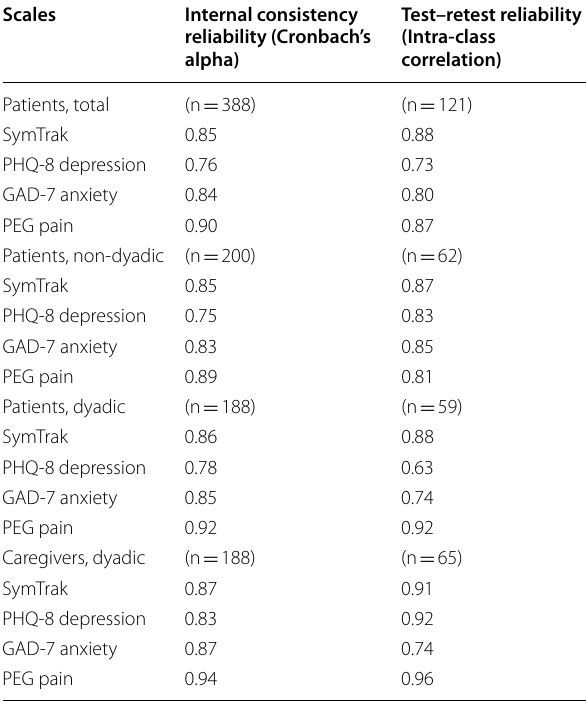
Table 2 Internal Consistency and Test–Retest Reliability of the Four Scales Scales Internal consistency Test–retest reliability reliability (Cronbach’s alpha)